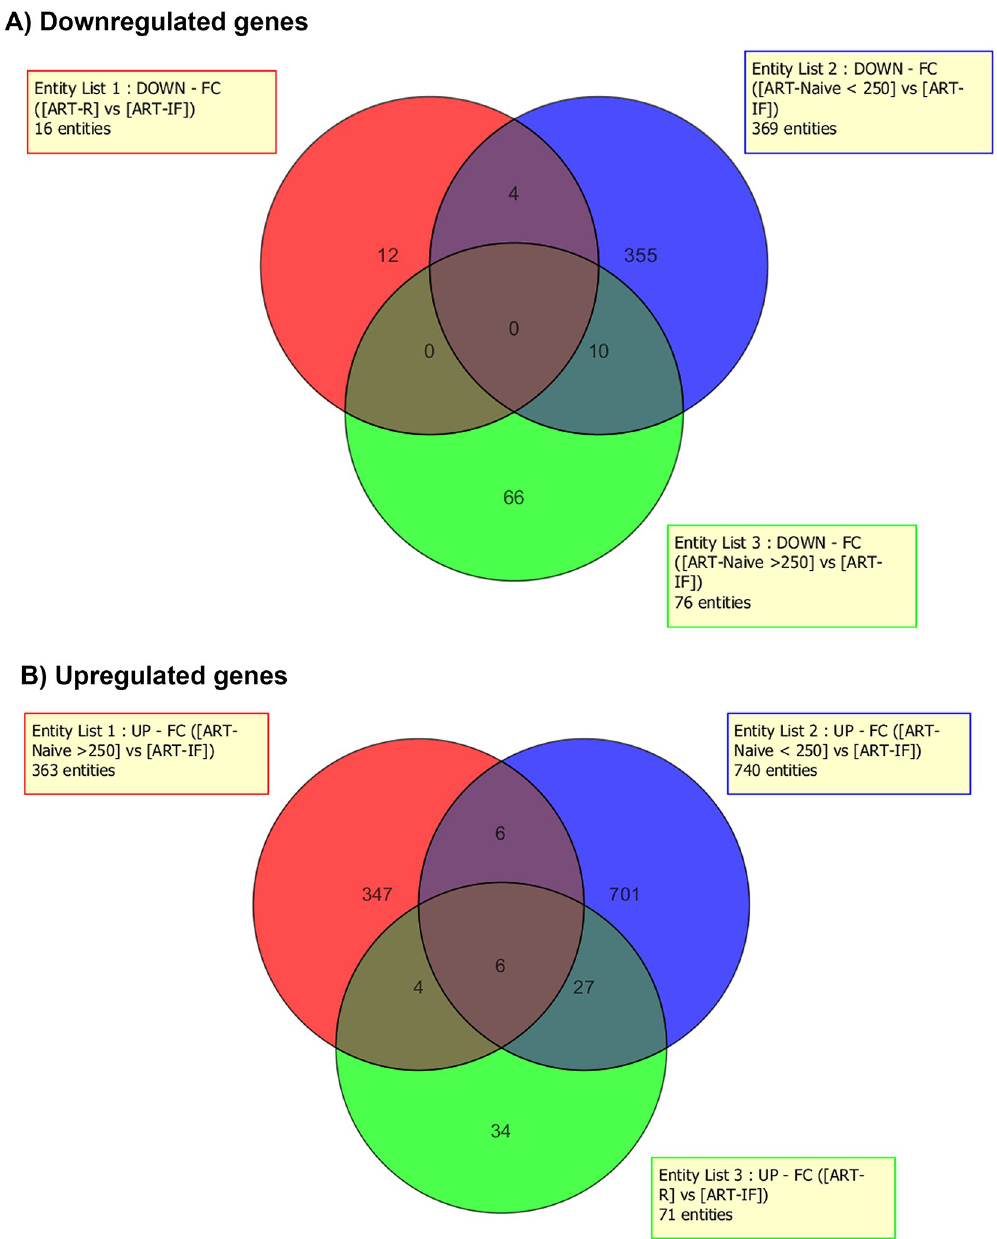
Fig 1. Venn diagram showing the downregulated and upregulated genes. Briefly, among HIV infected, overall, 16 probe sets (10 genes) significantly up-regulated and 71 probe sets (60 genes) down-regulated ( > 2-fold change) in ART-IF as compared to